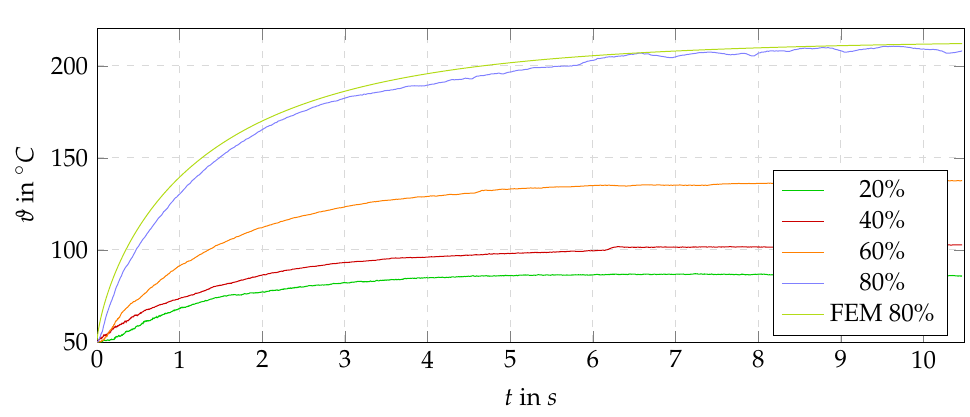
Figure 7. Measured profile of the preheating temperature in the area of the welding zone at different power settings of the induction generator.